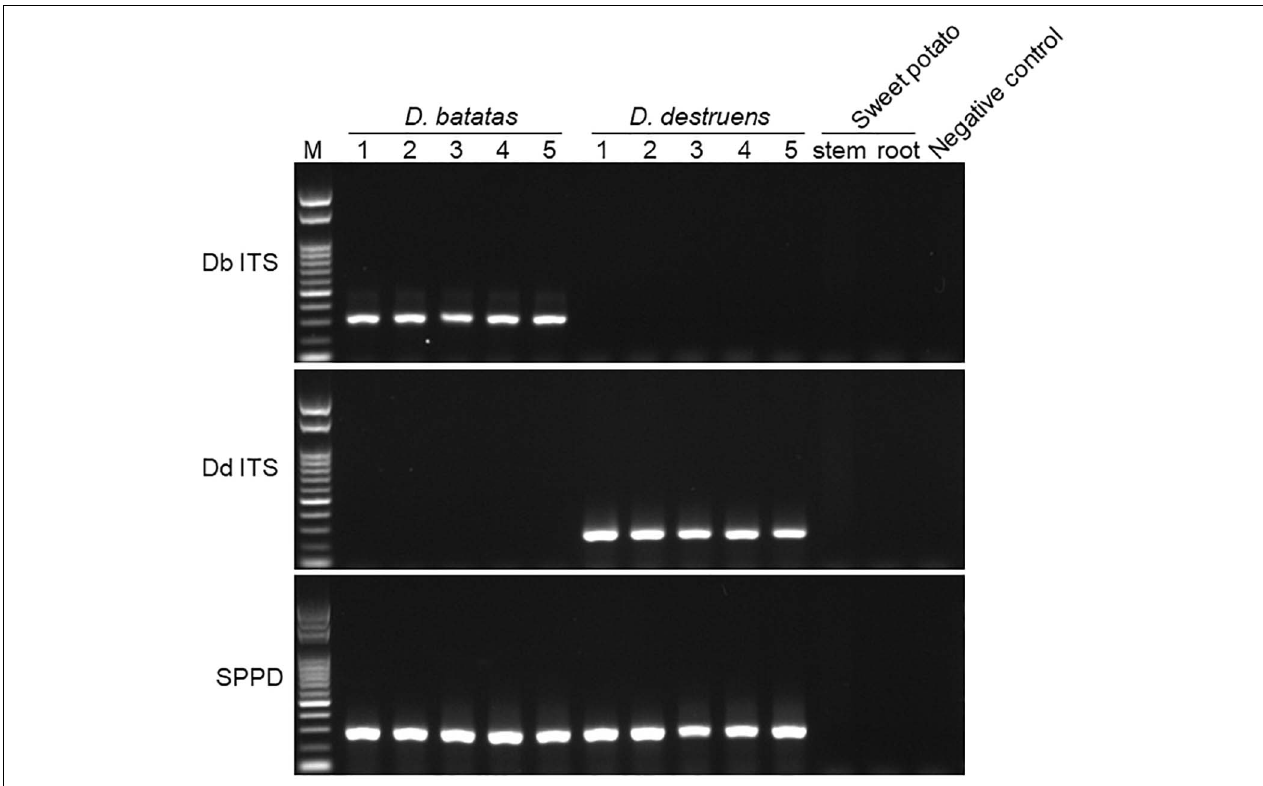
FIGURE 1 | Amplification of Diaporthe batatas and Diaporthe destruens DNA by conventional PCR. Newly developed primer sets Db ITS and Dd ITS were tested against D. batatas and D. destruens DNA, respectively, in five individual PCR amplifications. The SPPD primer set previously reported was used for comparison. Template DNA (5 ng µ L − 1 ) were prepared from culture plates of D. batatas strain MOKM-3S-B and D. destruen s strain KTJ-1R-a, respectively. Stem and tuberous DNA of healthy sweet potato plants as well as no template were used as negative controls. Amplicons produced by Db ITS, Dd ITS, and SPPD primer sets were 317, 258, and 289 bp, respectively. M,